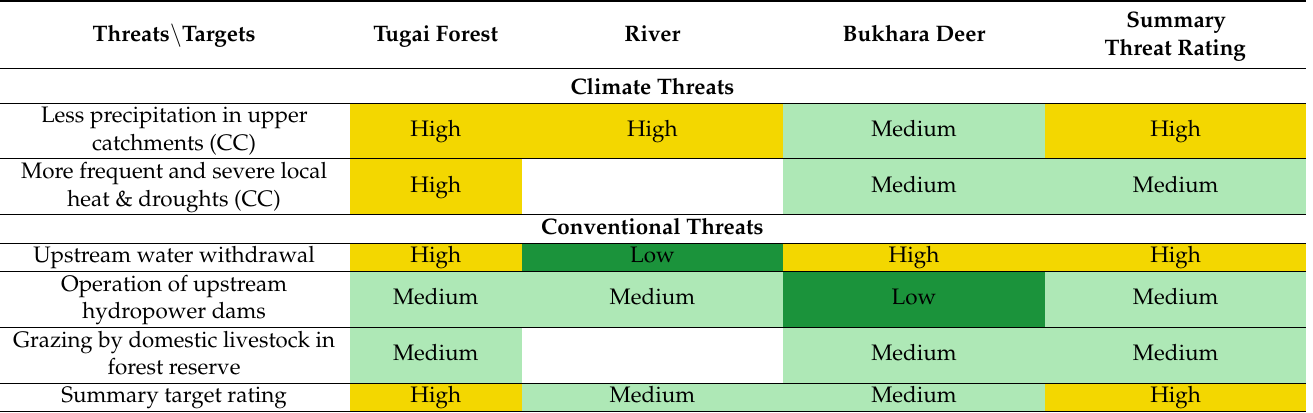
Table 1. Example Rating of Conventional and Climate Threats to Ecosystems in the Tugai Nature Reserve. The threat rating table shows ratings for each threat-target combination, as well as summary ratings for each threat (in the column on the right) and summary ratings for each target (in the bottom